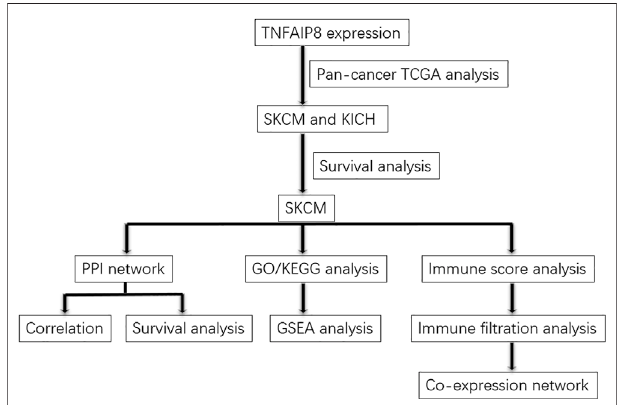
FIGURE 1 | Bioinformatics work fl ow of this